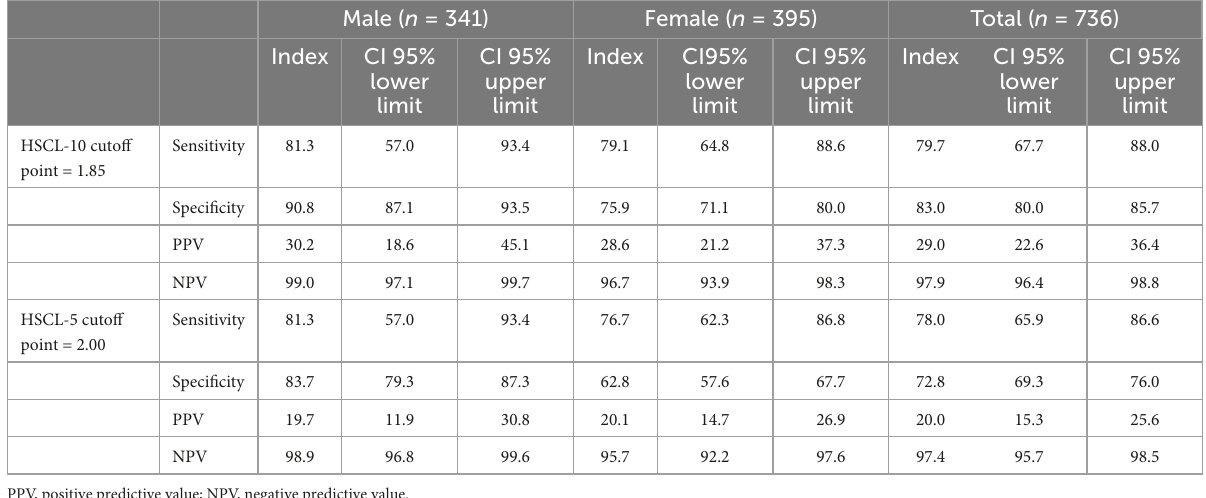
Male ( n = 341) Female ( n = 395) Total ( n = 736) Index CI 95% CI 95% Index CI95% CI 95% Index CI 95% CI 95% lower upper lower upper lower upper limit limit limit limit limit